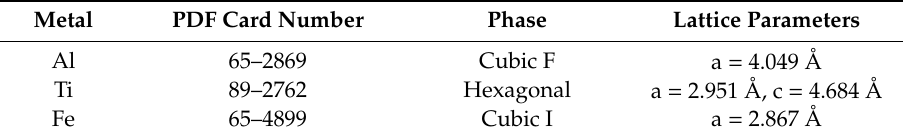
Table 2. Percentage by weight of phases in samples milled for 300 h and milled for 300 h and sintered at 900 °C for 1 h.